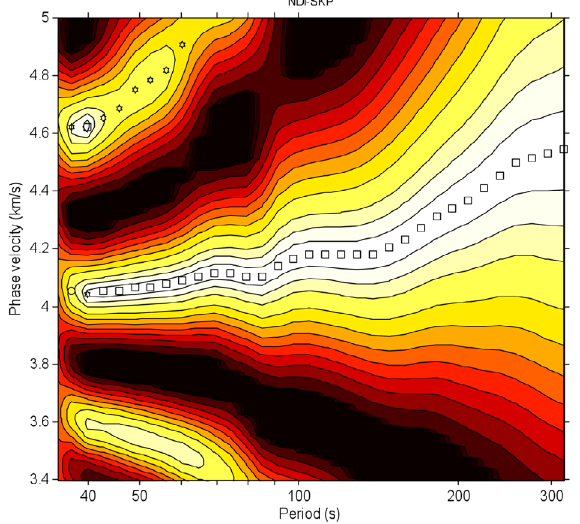
Figure 3. An example of Rayleigh wave phase velocity measure- ment between NDI and SKP using the vertical records (Figure 2) from the event 2 (Table 2). White and black areas show positive and negative amplitude part in the cross correlated waveform at each period. A peak (crest) is shown by a symbol, which is properly cho- sen as phase